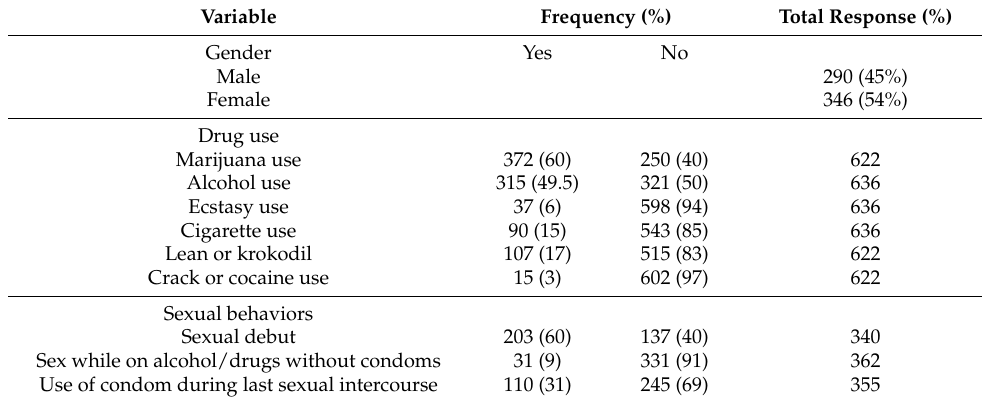
Table 1. Sample characteristics ( N = 636).